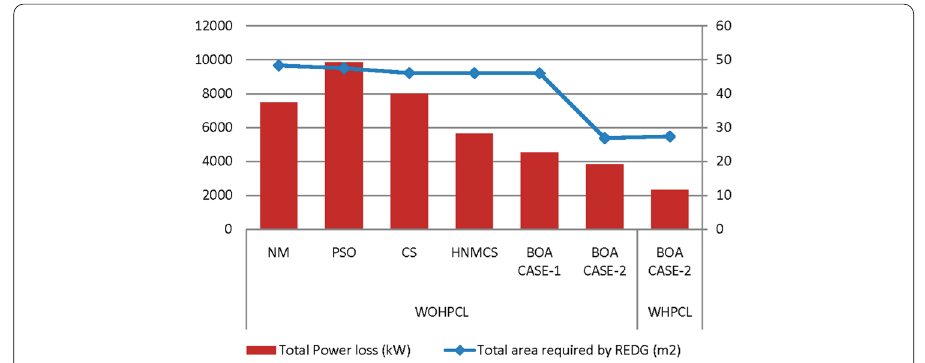
Fig. 4 Comparison of power loss vs operational area required by REDG units for various optimization algorithms for 33-bus hybrid AC/DC distribution micro-grid